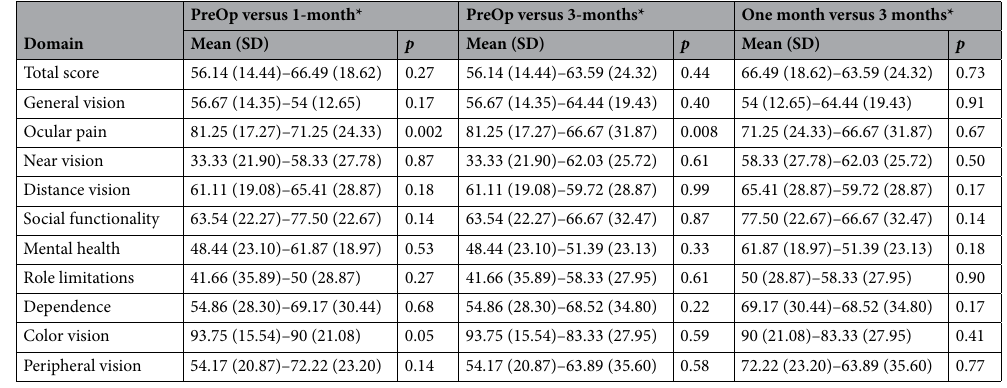
Table 3. Comparison of quality-of-life related variables of pre-and post-surgical evaluations, in other causes of vitrectomy. PreOp Preoperative. *Paired student’s